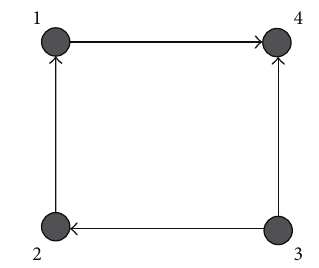
Figure 1: The interconnection topology G .